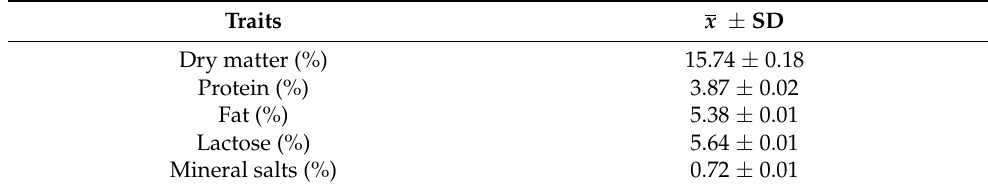
Table 1. Chemical composition of bulk tank milk ( x ± SD).